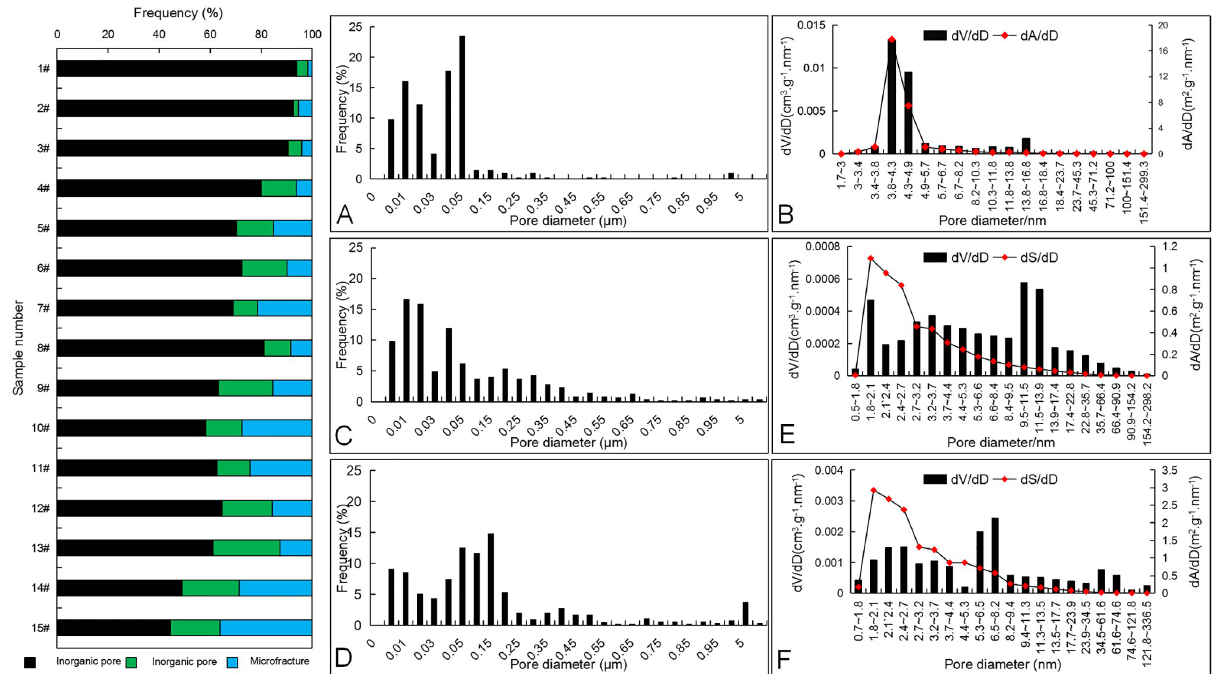
Fig 9. Pore types and structure characteristic parameters in different shales by SEM and Image-pro Plus. Aperture distribution histogram of all pores in (A) Sample 1# from Upper Longtan member; (B) Sample 6# from Middle Longtan member; (C) Sample 13# from Lower Longtan member. Distribution histogram of specific pore volume and specific surface area for (D) Sample 1# from Upper Longtan member; (E) Sample 6# from Middle Longtan member; (F) Sample 13# from Lower Longtan member.